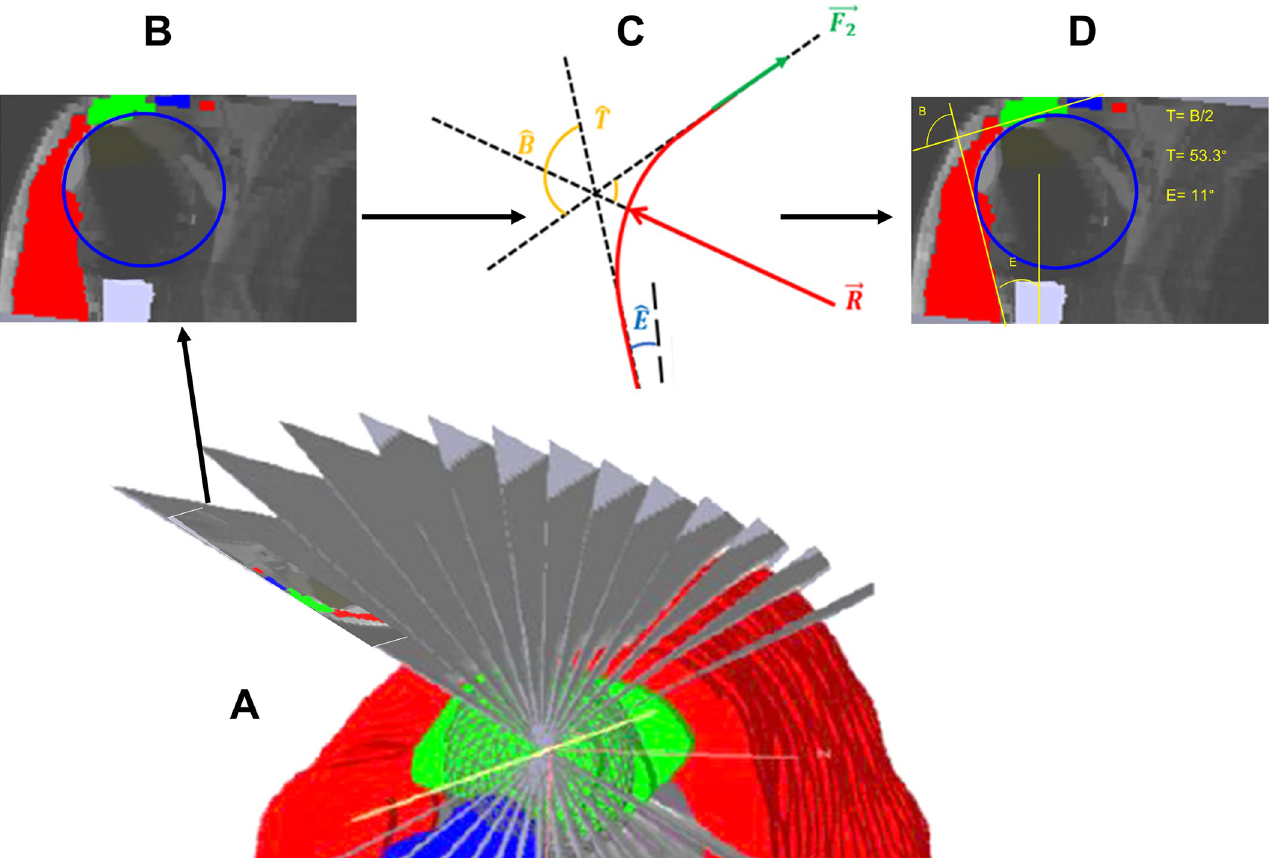
Fig 5. Summary of the steps from the selection of slices to angle measurements. (A) The 3D model is segmented in several plane sections according to the methodology presented above. (B) After selecting the slices according to the anatomical description by Sakoma et al . [22] and in which a portion of the ILSS is “stamped”, the biomechanical model developed by Billuart et al . [20] (C) is used to carry out the angle measurements (D) .